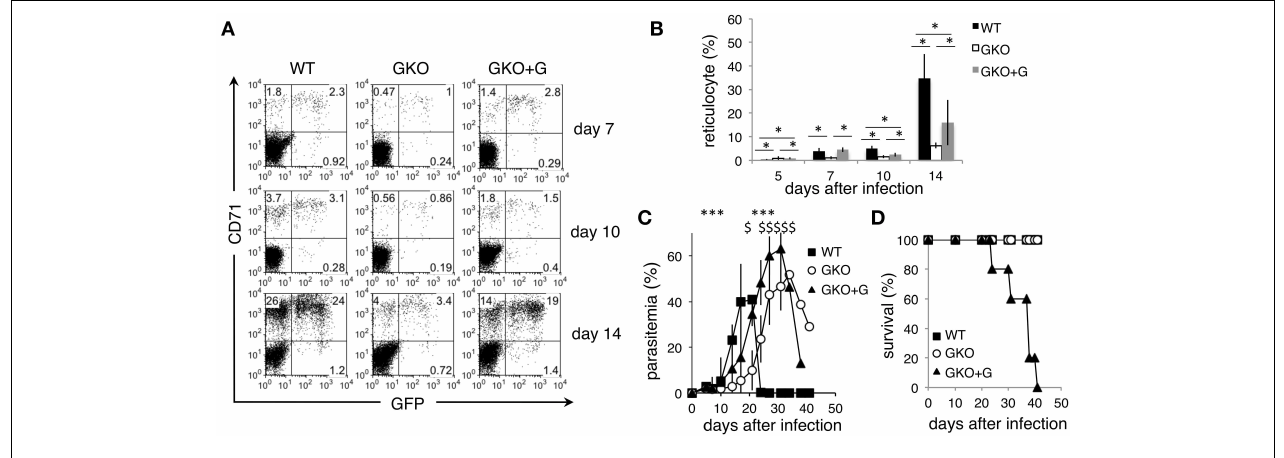
FIGURE 3 | Course of infection with PyNL in GKO mice injected with recombinant IFN- γ . WT (closed squares) and GKO mice were infected with GFP-PyNL, and the GKO mice were left untreated (open squares) or treated with recombinant IFN- γ (GKO+G, closed triangles). (A,B) Blood samples were analyzed for reticulocytes infected with PyNL as in Figures 2C,D .